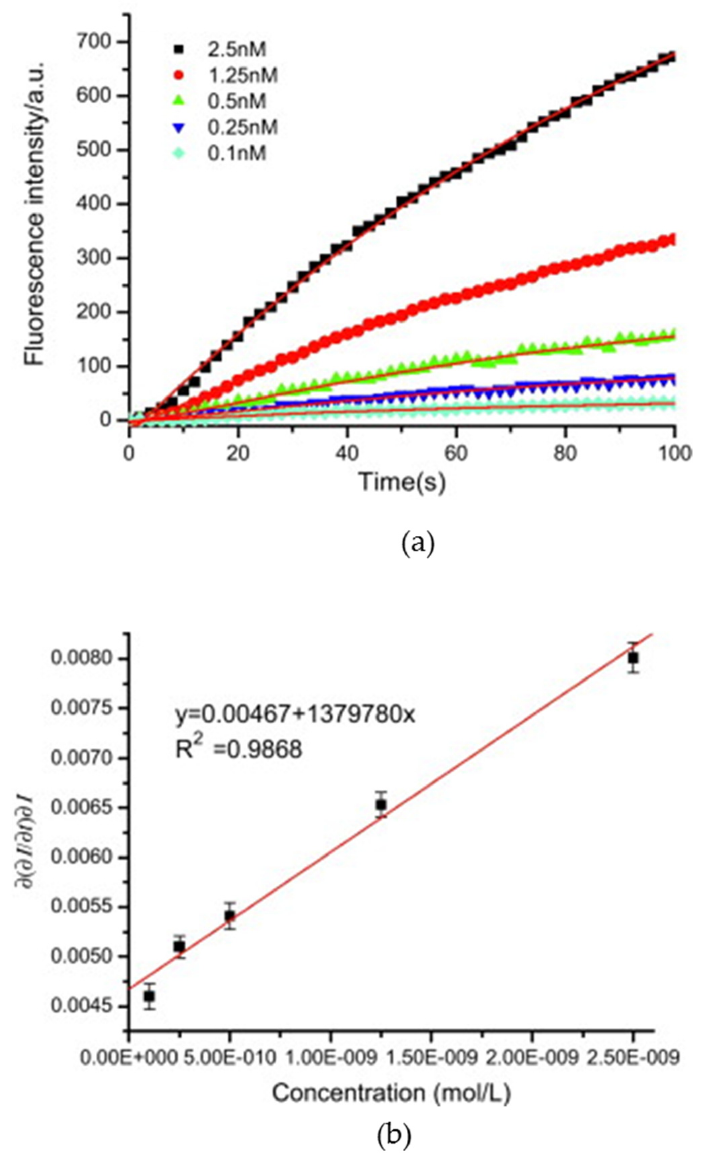
Figure 8. ( a ) Kinetic curves representing the molecular interactions on the sensor surface. ( b ) Determination of binding kinetics for DNA hybridization. Reprinted with permission from [31].